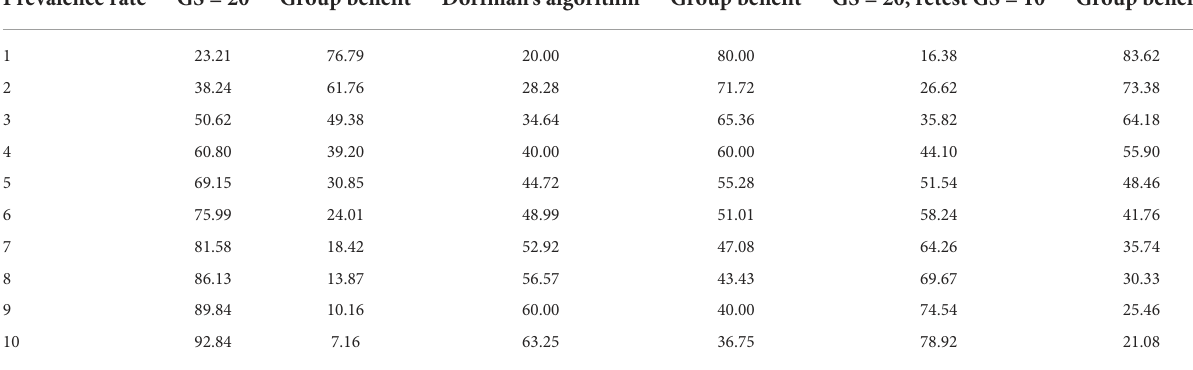
TABLE 1 Efficiency of different pooling strategies and group benefits for 100